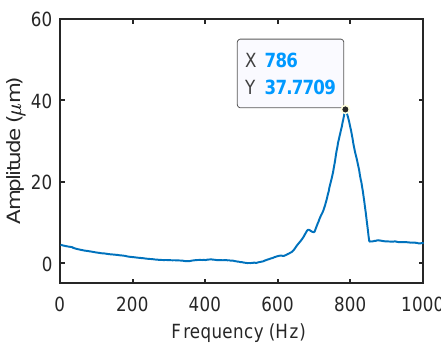
Figure 11. Frequency response test result of the gripping displacement.